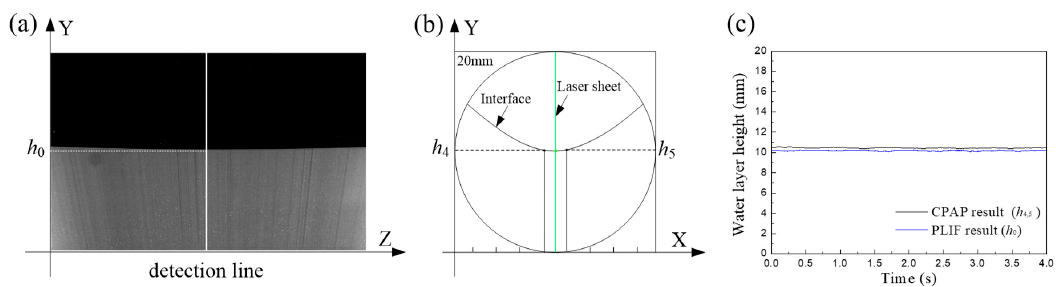
Figure 12. Interfacial heights at pipe center detected by the PLIF and CPAP: ( a ) Interfacial height extracted from the PLIF image; ( b ) Interface height detected by the CPAP; ( c ) Time-dependent series of the interface heights.